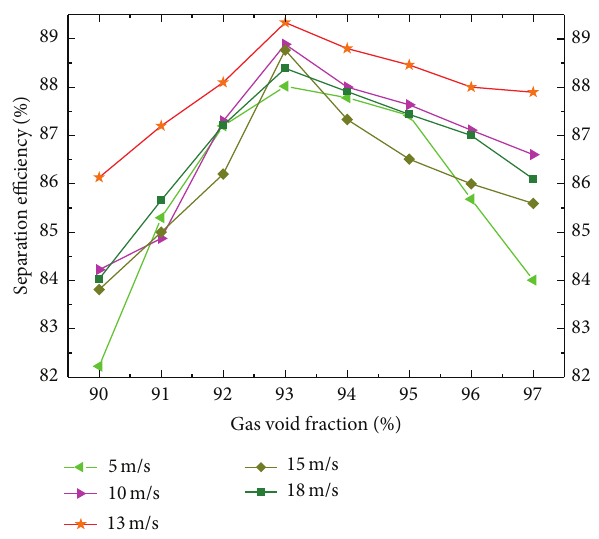
Figure 12: The influence of gas void fraction on separation effi- ciency.